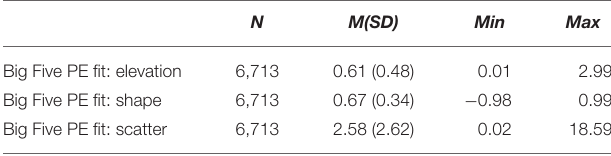
TABLE 3 | Descriptive statistics: longitudinal outcome measures of subjective wellbeing.